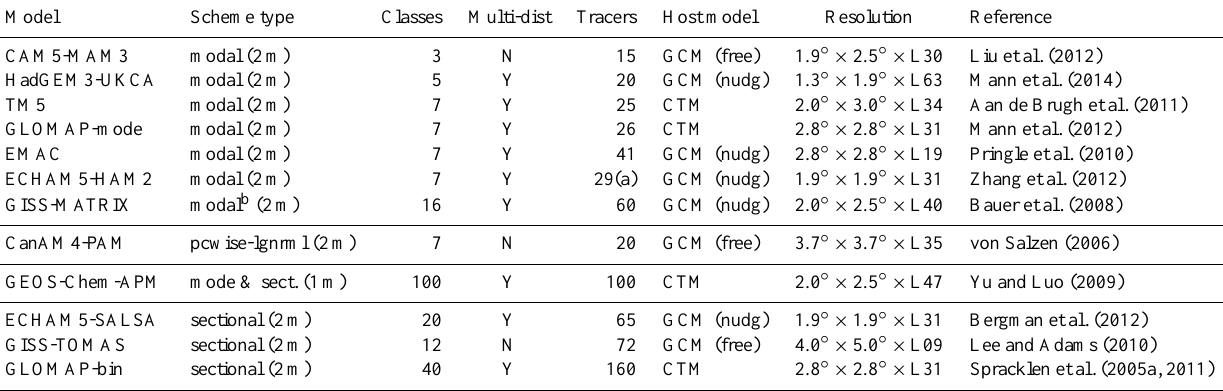
Table 1. List of participating global aerosol microphysics models. Two-moment schemes (2m) carry number and mass in each size class whereas single-moment (1m) schemes carry only mass. Most models are modal or sectional but CanAM4-PAM uses the piecewise log- normal approach (pcwise-lgnrml). The “Multi-dist” column indicates whether the scheme includes multiple distributions, i.e. whether it is possible to have two particles of the same size but different composition. The “Tracers” column indicates the total number of transported aerosol tracers for each scheme (the sum of the number concentrations and component masses over all size classes). Schemes running in free- running (free) General Circulation Models (GCMs) submitted multi-annual monthly means from 5yr simulations whereas nudged (nudg) GCMs and CTMs submitted monthly-mean results driven by 2006 meteorological